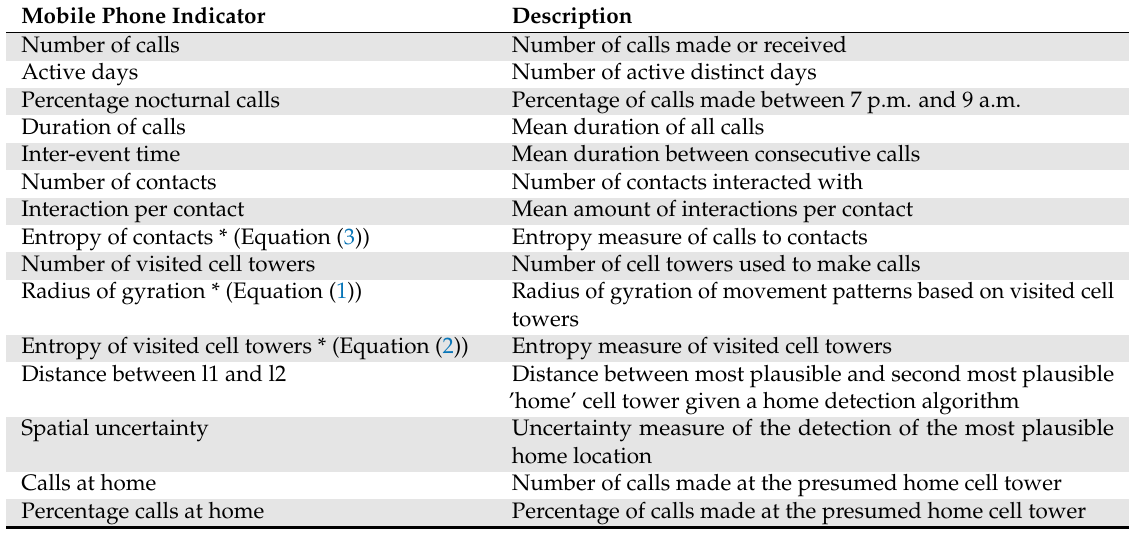
Table 1. Description of mobile phone